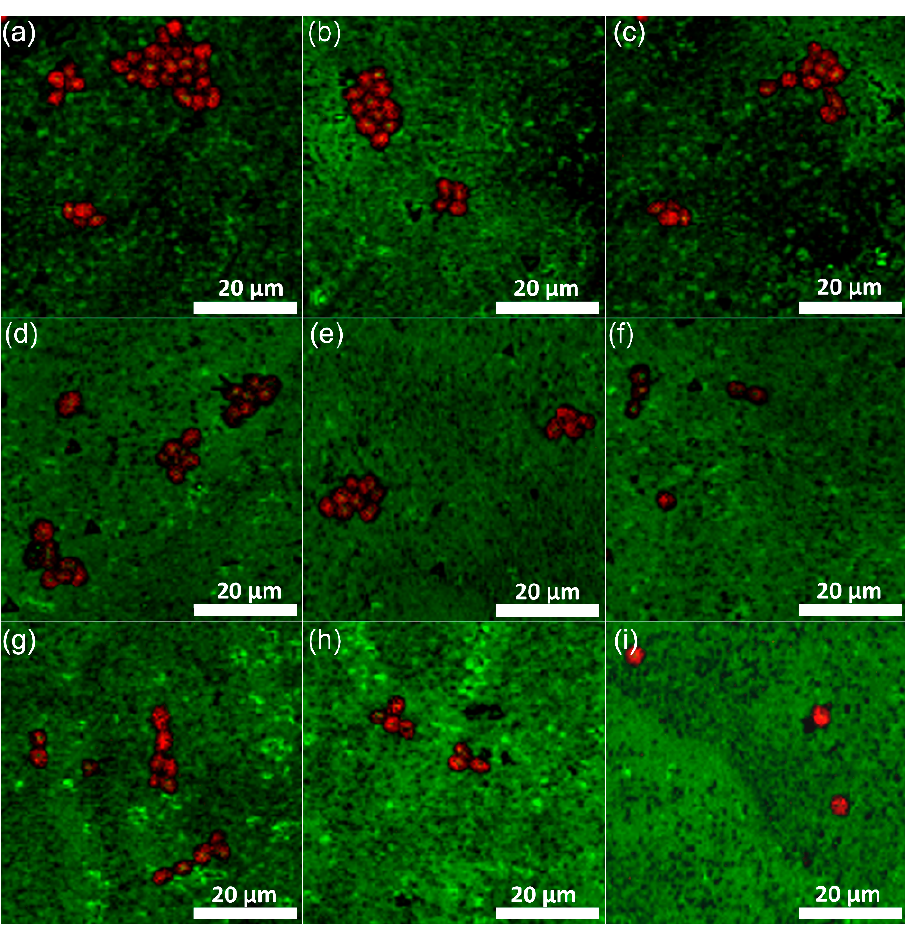
Figure 10. CLSM images of Candida albicans ATCC 10231 cell development on the surface of CS- HAp_1 ( a – c ), CS-HAp_2 ( d – f ), and CS-HAp_3 ( g – i ) after 24 h ( a , d , g ), 48 h ( b , e , h ), and 72 h ( c , f , i ) of incubation.